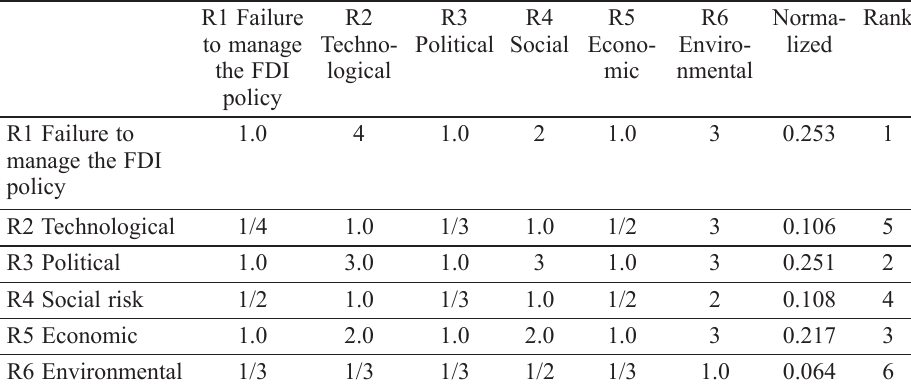
Table 12. Pair-wise comparison and determination of priorities in the line with the risk merit